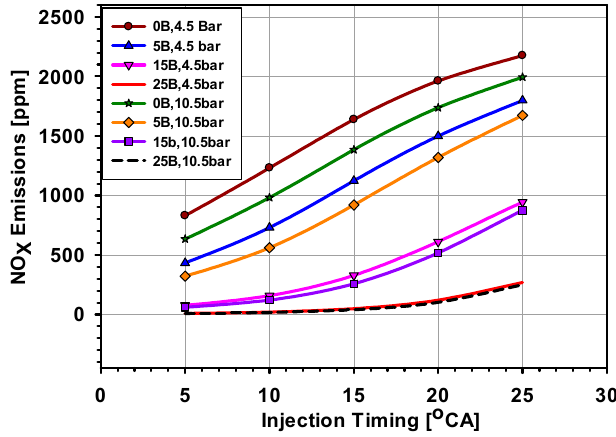
Figure 8. Variations of NO X